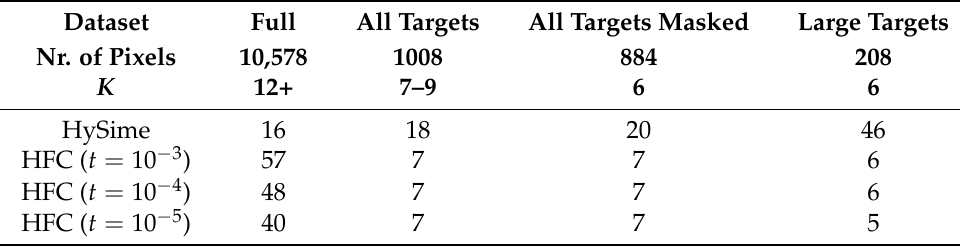
Table 1. Results of dimensionality estimation on four subsets of the DLR HySU dataset. Dataset Full All Targets All Targets Masked Large